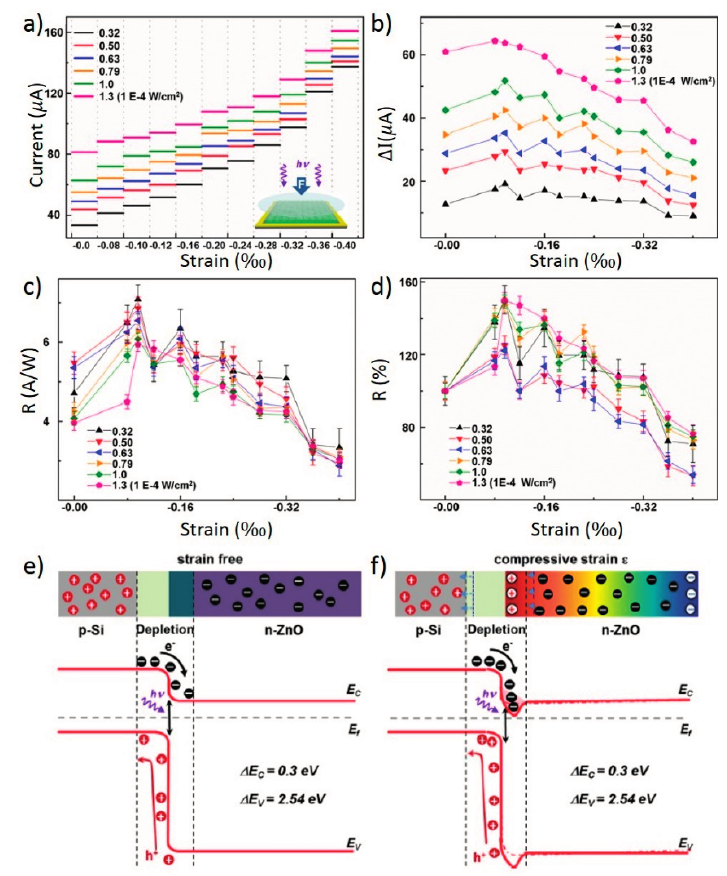
Figure 10. Piezo-phototronic effect. ( a ) Output current of the photodetector under different strain and illumination conditions at 2 V bias. The inset is a schematic of experimental setup; ( b ) Photocurrent; ( c ) photoresponsivity; and ( d ) relative change of photoresponsivity of the device under different strain and illumination conditions at 2 V bias; ( e , f ) Schematic band diagrams of a p-Si/n-ZnO heterojunction ( e ) without and ( f ) with compressive strain applied to illustrate the working mechanism of piezo-phototronic effect of the optimized p-n junction photodetector. Adapted from [81] with permission from American Chemical Society. Copyright